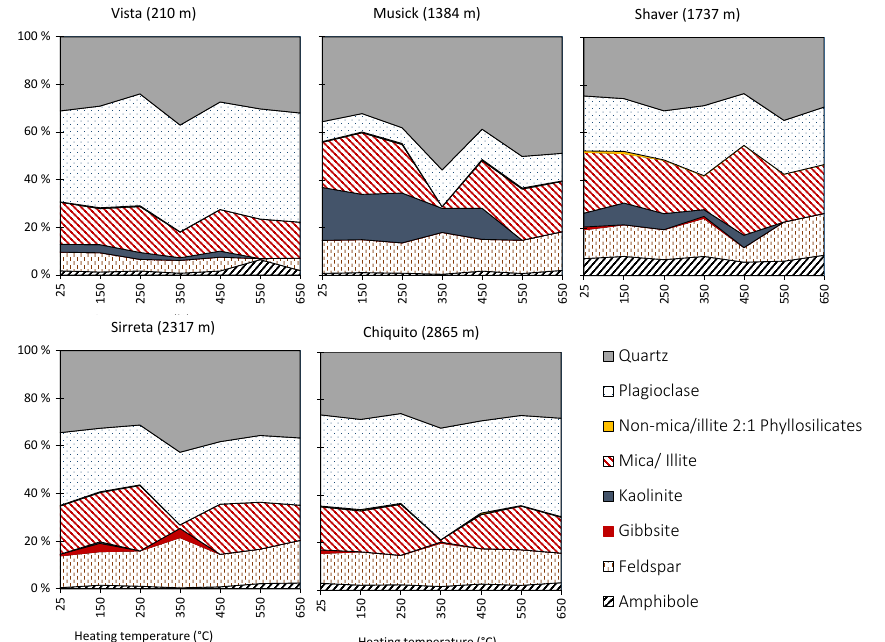
Figure 7. Relative amounts of minerals identified from powder XRD.